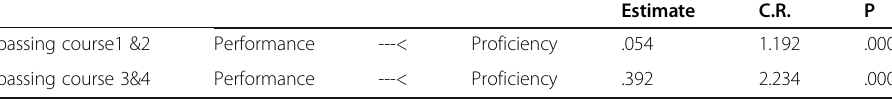
Table 10 Standardized Regression Weights: (data - Default model) for participants that they passed current Aviation courses (CBLT courses) held by the Iranian general directorate of ATM